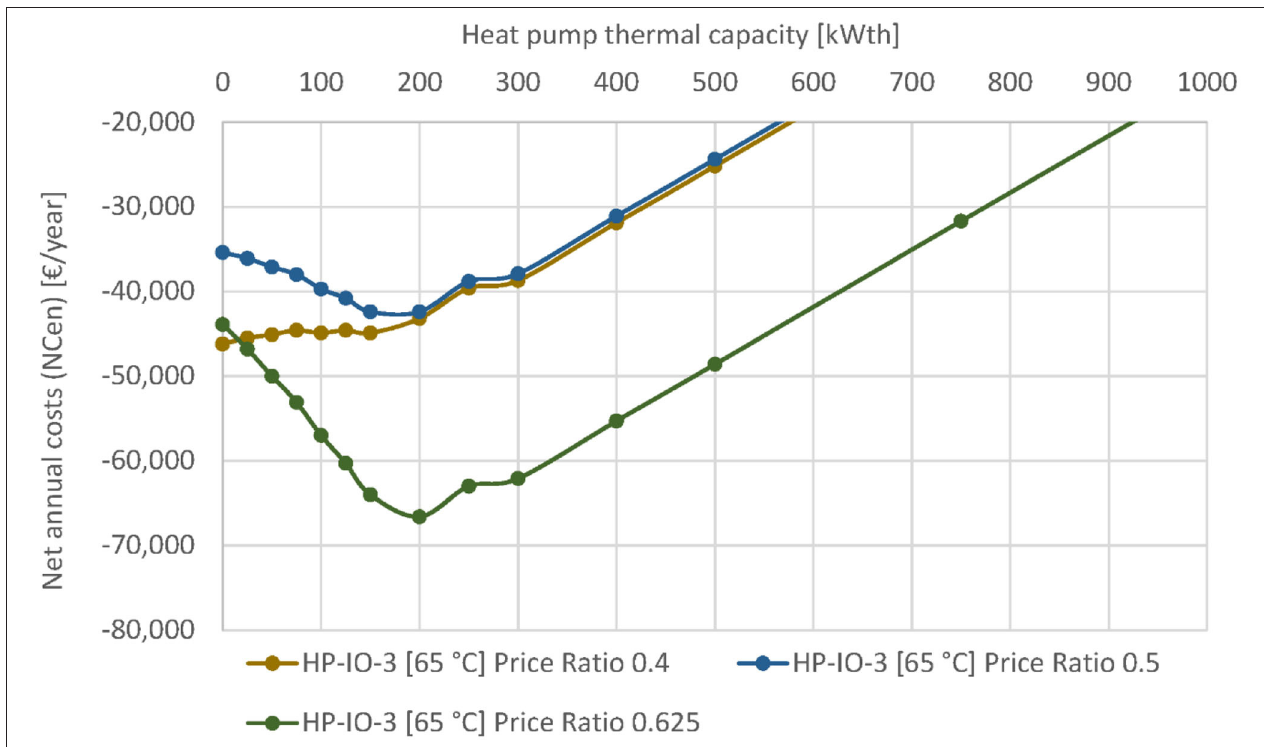
FIGURE 8 | Net annual costs ( NC En ) of HP-IO-3 (65 ◦ C) at three different price ratios. Negative net annual costs are net annual savings.